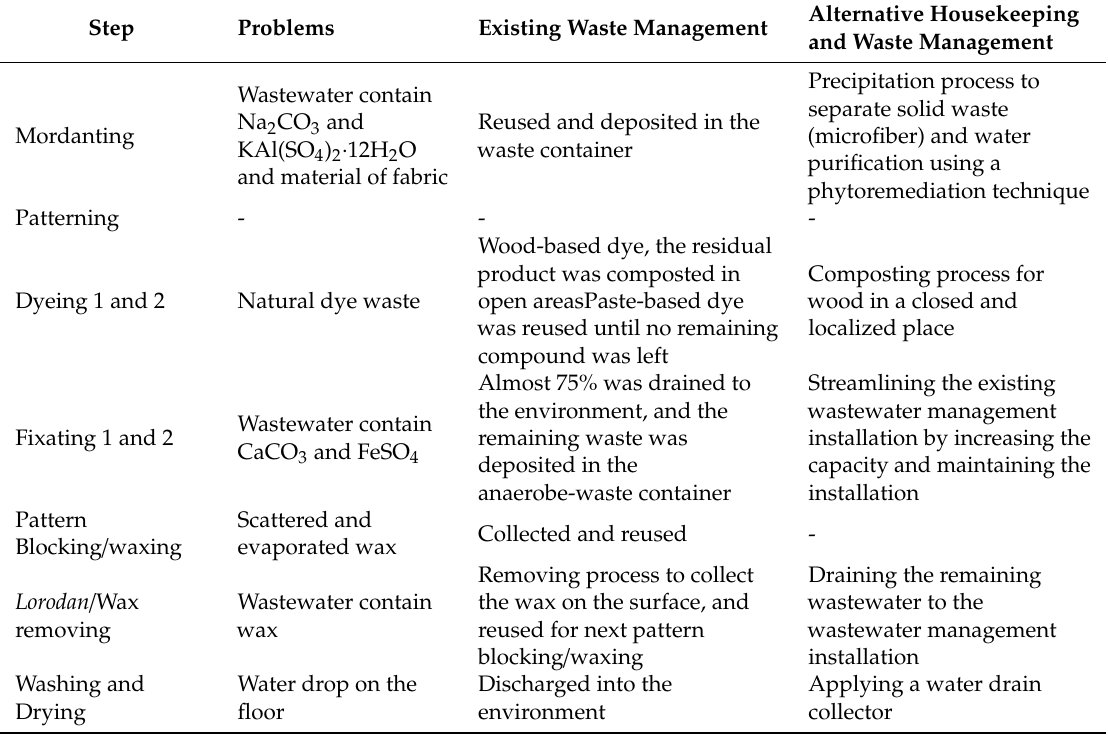
Table 3. Existing waste management in Zie